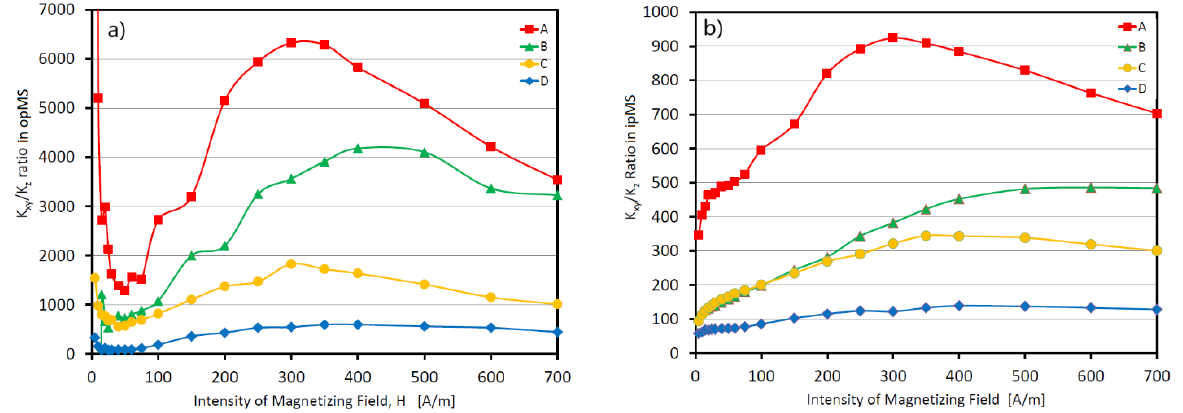
Figure 16. Variations in the K xy /K z ratio of the hematite single crystals (denoted A, B, C, D) with magnetizing low-field: ( a ) opMS, ( b ) ipMS. magnetizing low-field: ( a ) opMS, ( b )